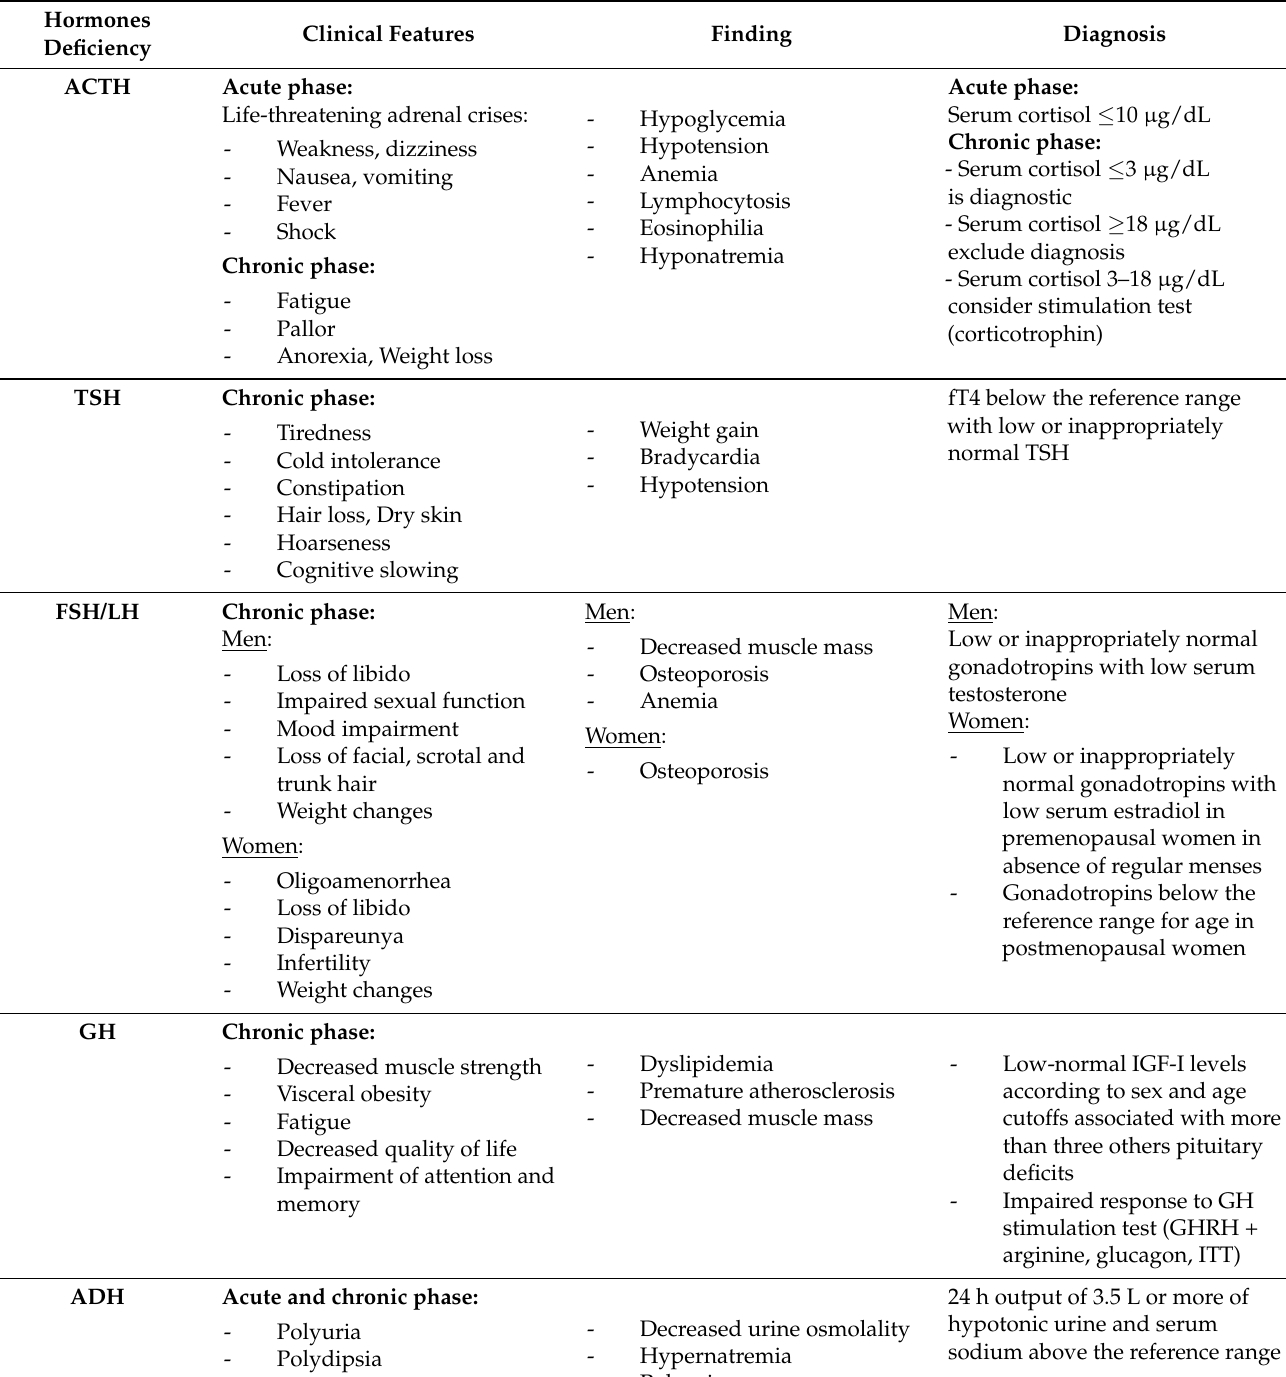
Table 1. Clinical features, investigative findings, and diagnostic criteria of post TBI hypopituitarism. Hormones